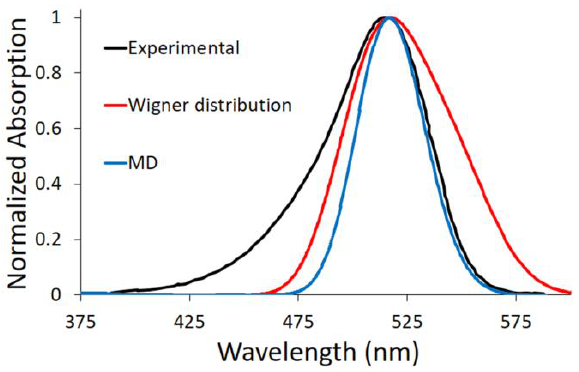
Figure 3. Comparison between simulated—by Wigner distribution and molecular dynamics (MD)—and experimental spectra (Adapted with permission from Helmy, S.; Oh, S.; Leibfarth, F.A.; Hawker, C.J.; Read de Alaniz, J. J. Org. Chem. 2014 , 79 , 11316–11329. Copyright 2017 American Chemical Society). Since time dependent-density functional theory (TD-DFT) is used, a red shift of 0.31 (0.48) eV is applied to the simulated spectra by Wigner distribution in order to better compare their shape with the experiment.